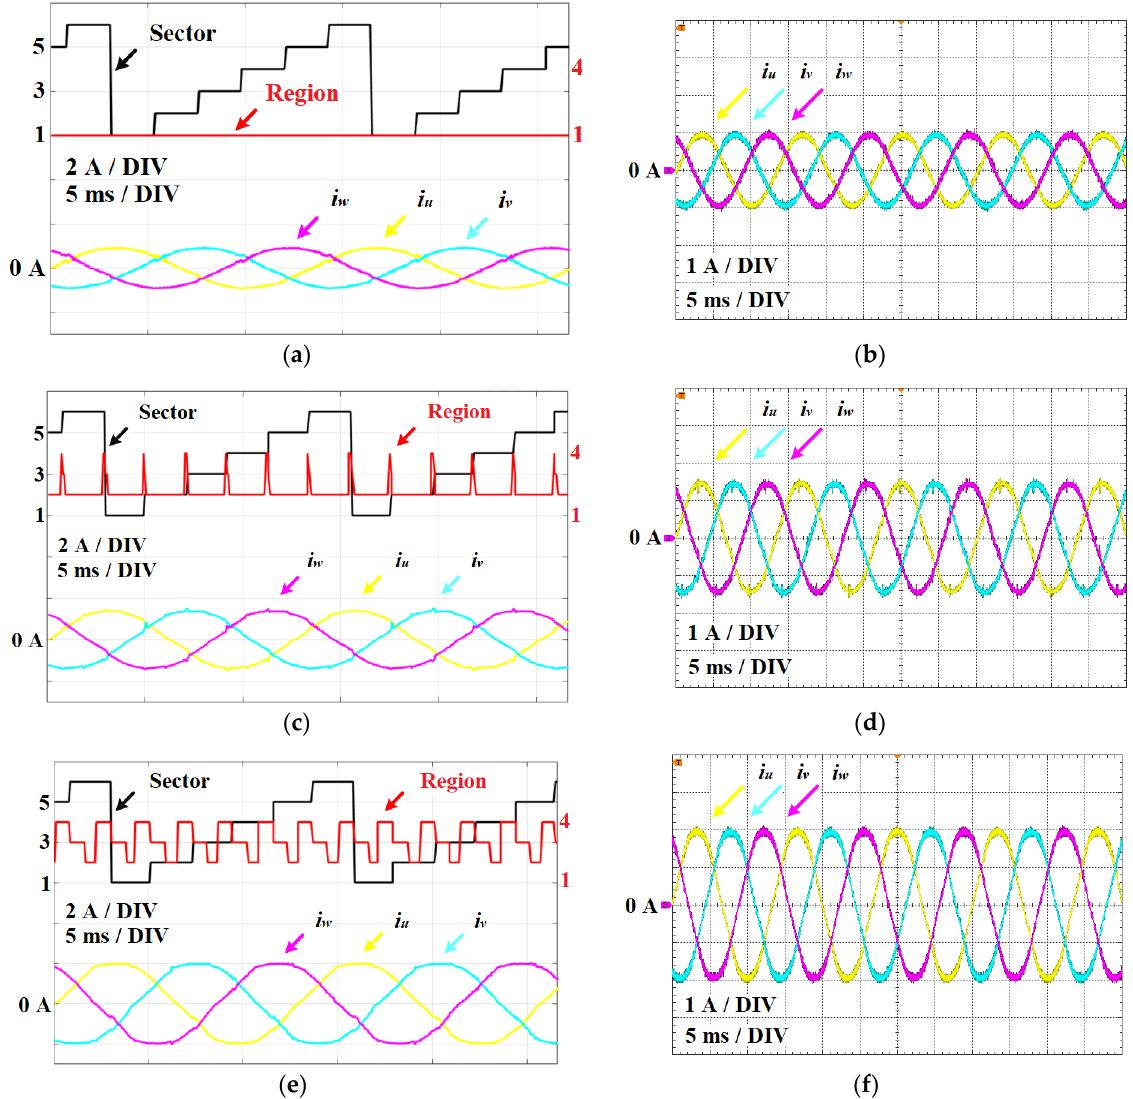
Figure 21. Single-shunt reconstruction of a three-phase current without SVM modification for f = 75 Hz: ( a ) m i = 0.4; ( c ) m i = 0.6; ( e ) m i = 0.8; scope-measured real three-phase currents for f = 75 Hz: ( b ) m i = 0.4; ( d ) m i = 0.6; ( f ) m i = 0.8.